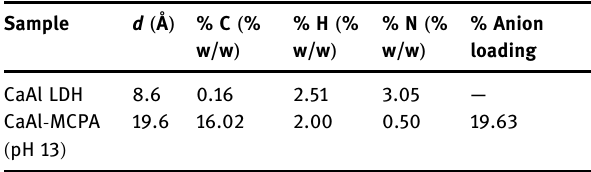
Table 1: Chemical composition of CaAl LDH and its nanocomposite, CaAl - MCPA Sample